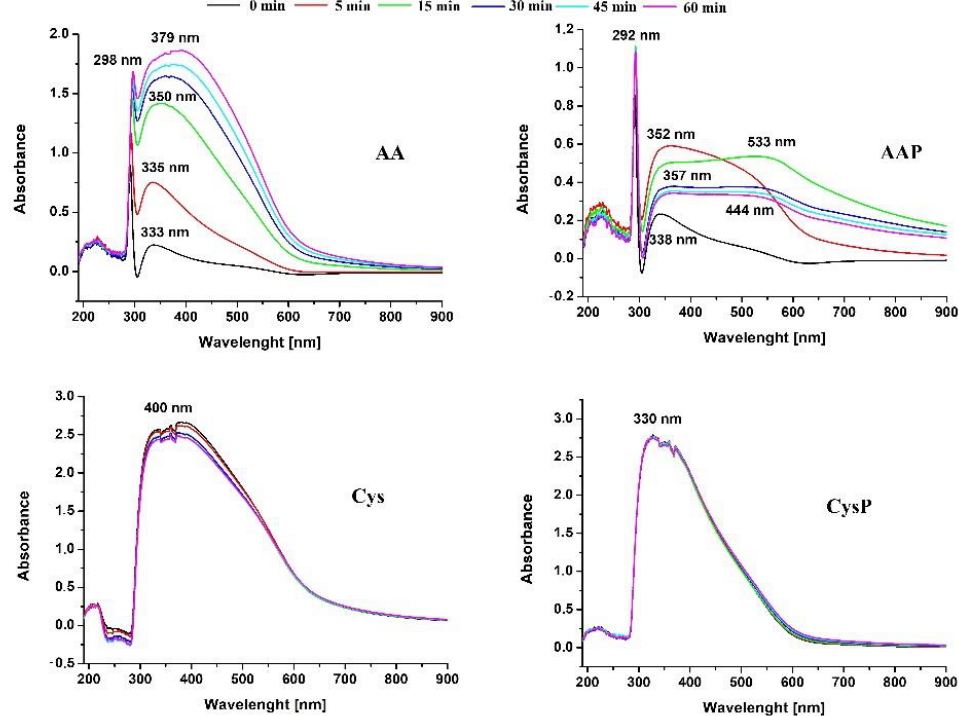
Figure 3. UV–visible spectra of SeNPs as a function of synthesis Figure 3. UV – visible spectra of SeNPs as a function of synthesis time.